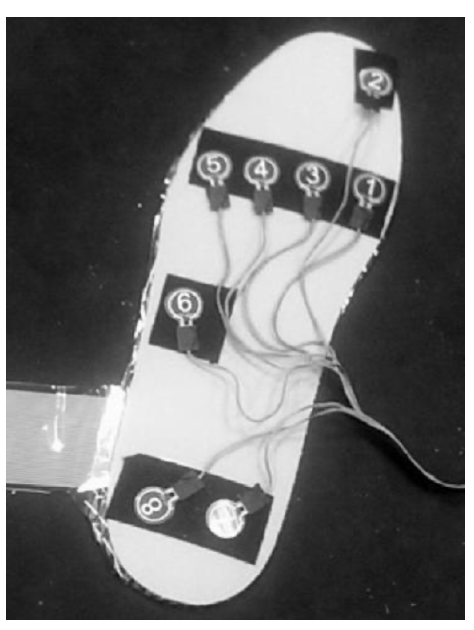
Figure A1. WalkinSense R (cid:13) sensor